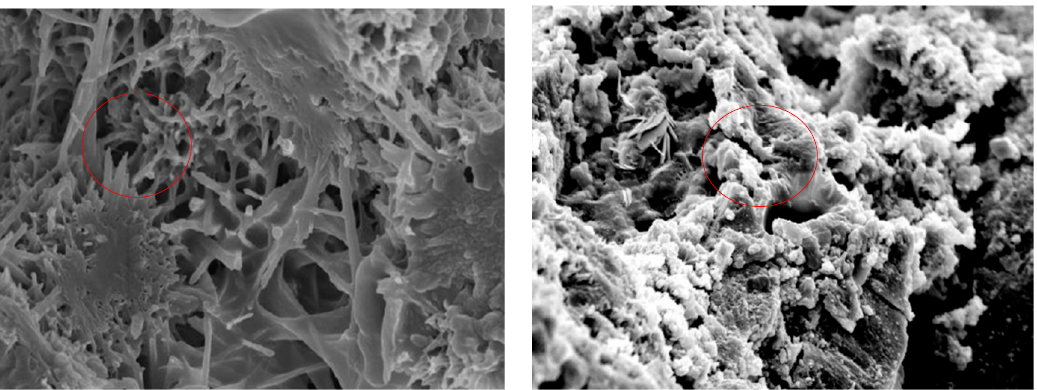
Figure 2. Microstructure of cement-emulsified asphalt mortar after cleaning.